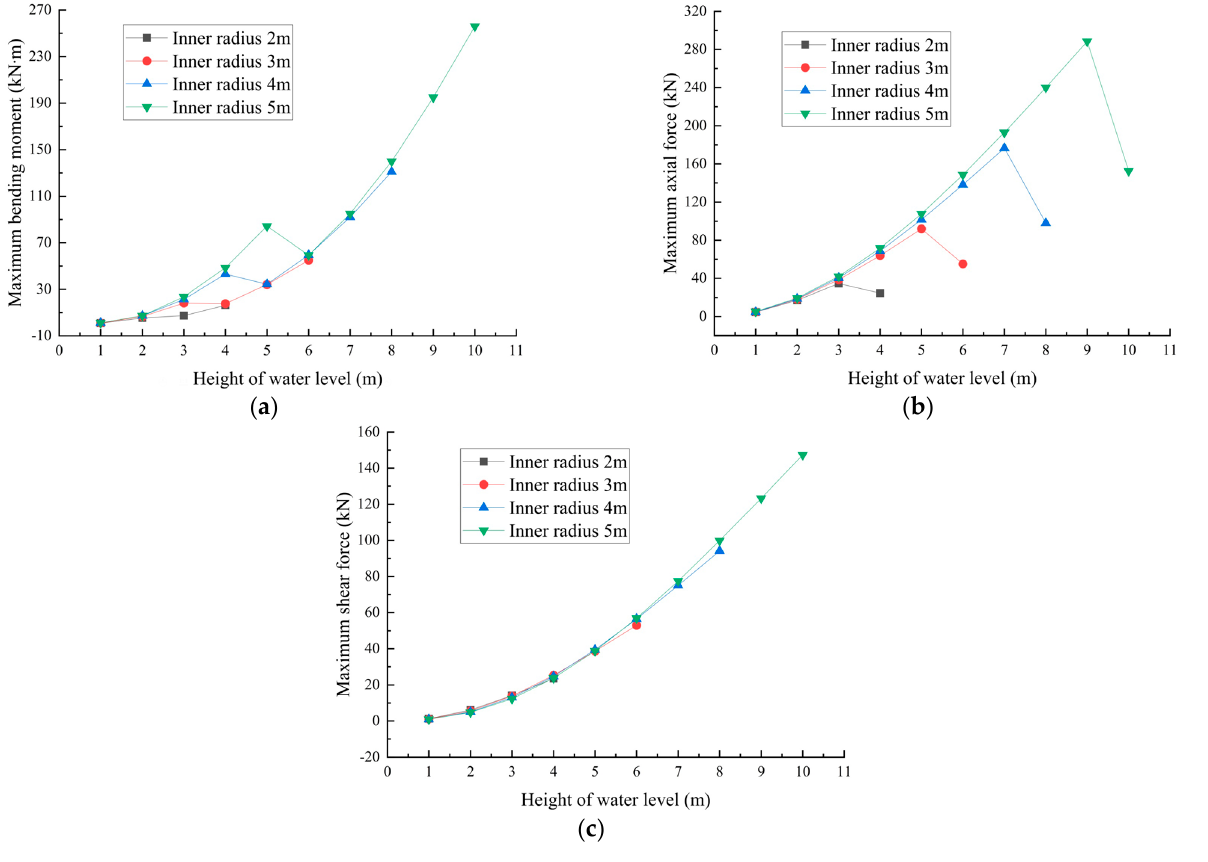
Figure 9. Influence of pressureless water conveyance level on the maximum internal force of lining. ( a ) Maximum bending moment. ( b ) Maximum axial force. ( c ) Maximum shear force.